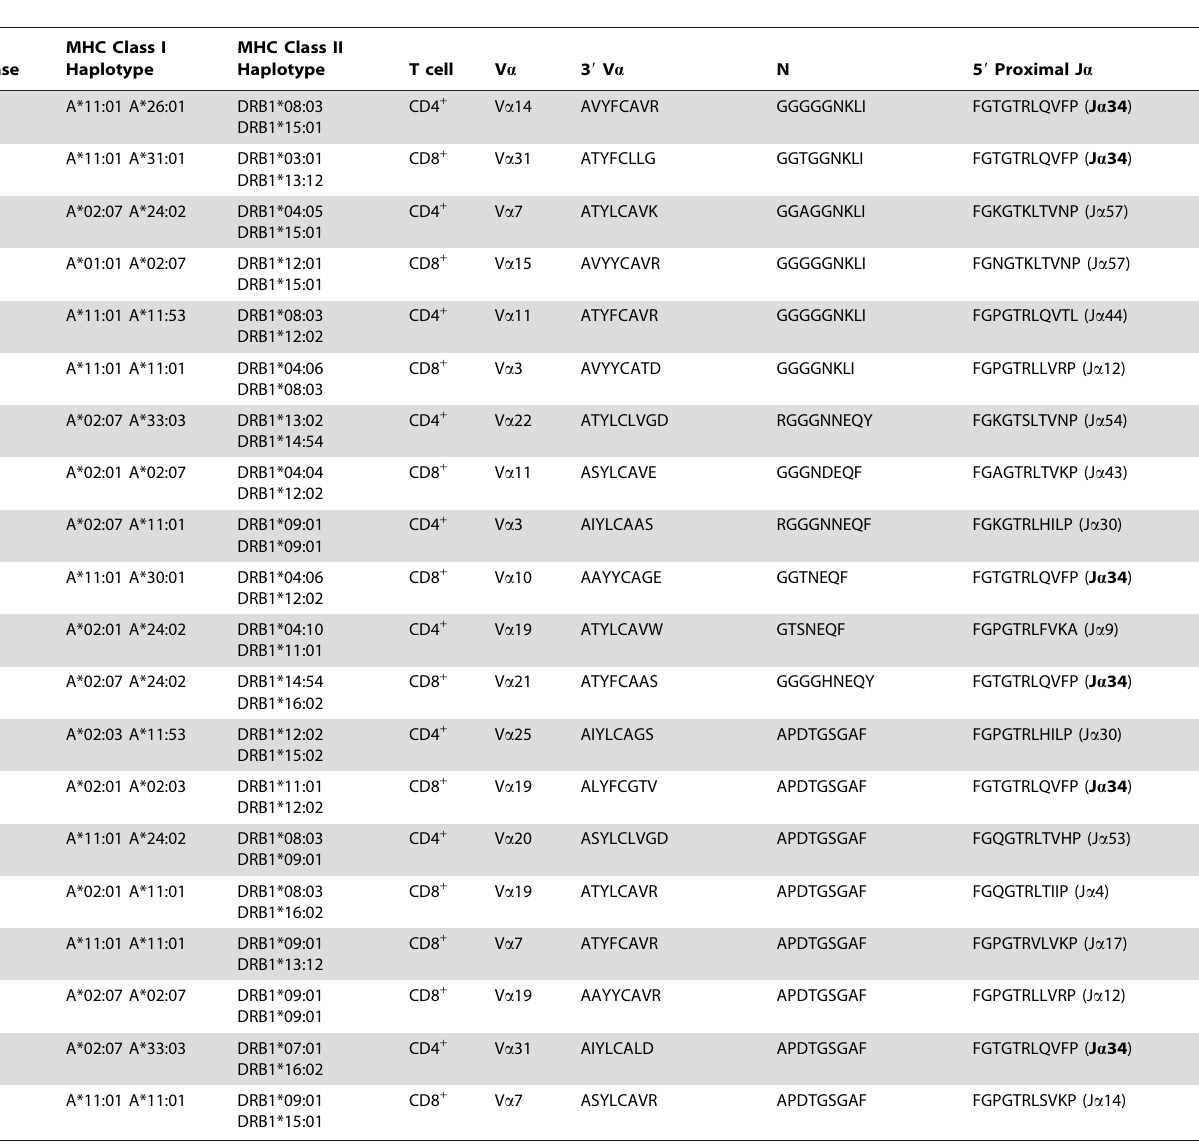
Table 2. Conserved CDR3 sequences from a chain of T cells exhibited a single peak on CDR3 spectratype analysis.